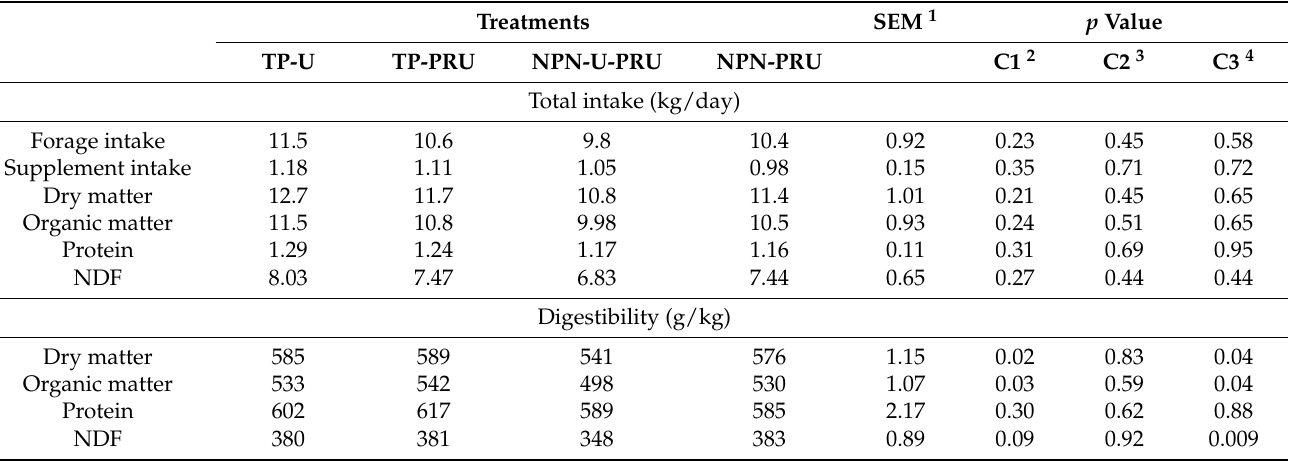
Table 3. Intake and digestibility in cannulated grazing Nellore steers (exp.1) supplemented with post-ruminal urea and conventional urea during the seasonal